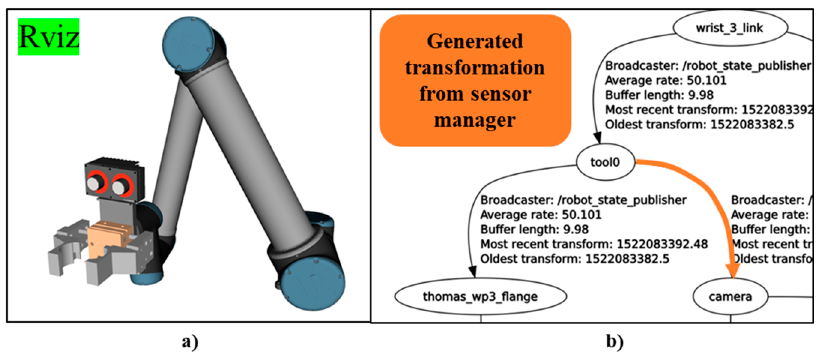
Figure 4. ( a ) The rc_visard 65 mounted on UR10. ( b ) Part of the rc_visard 65 TF-tree .